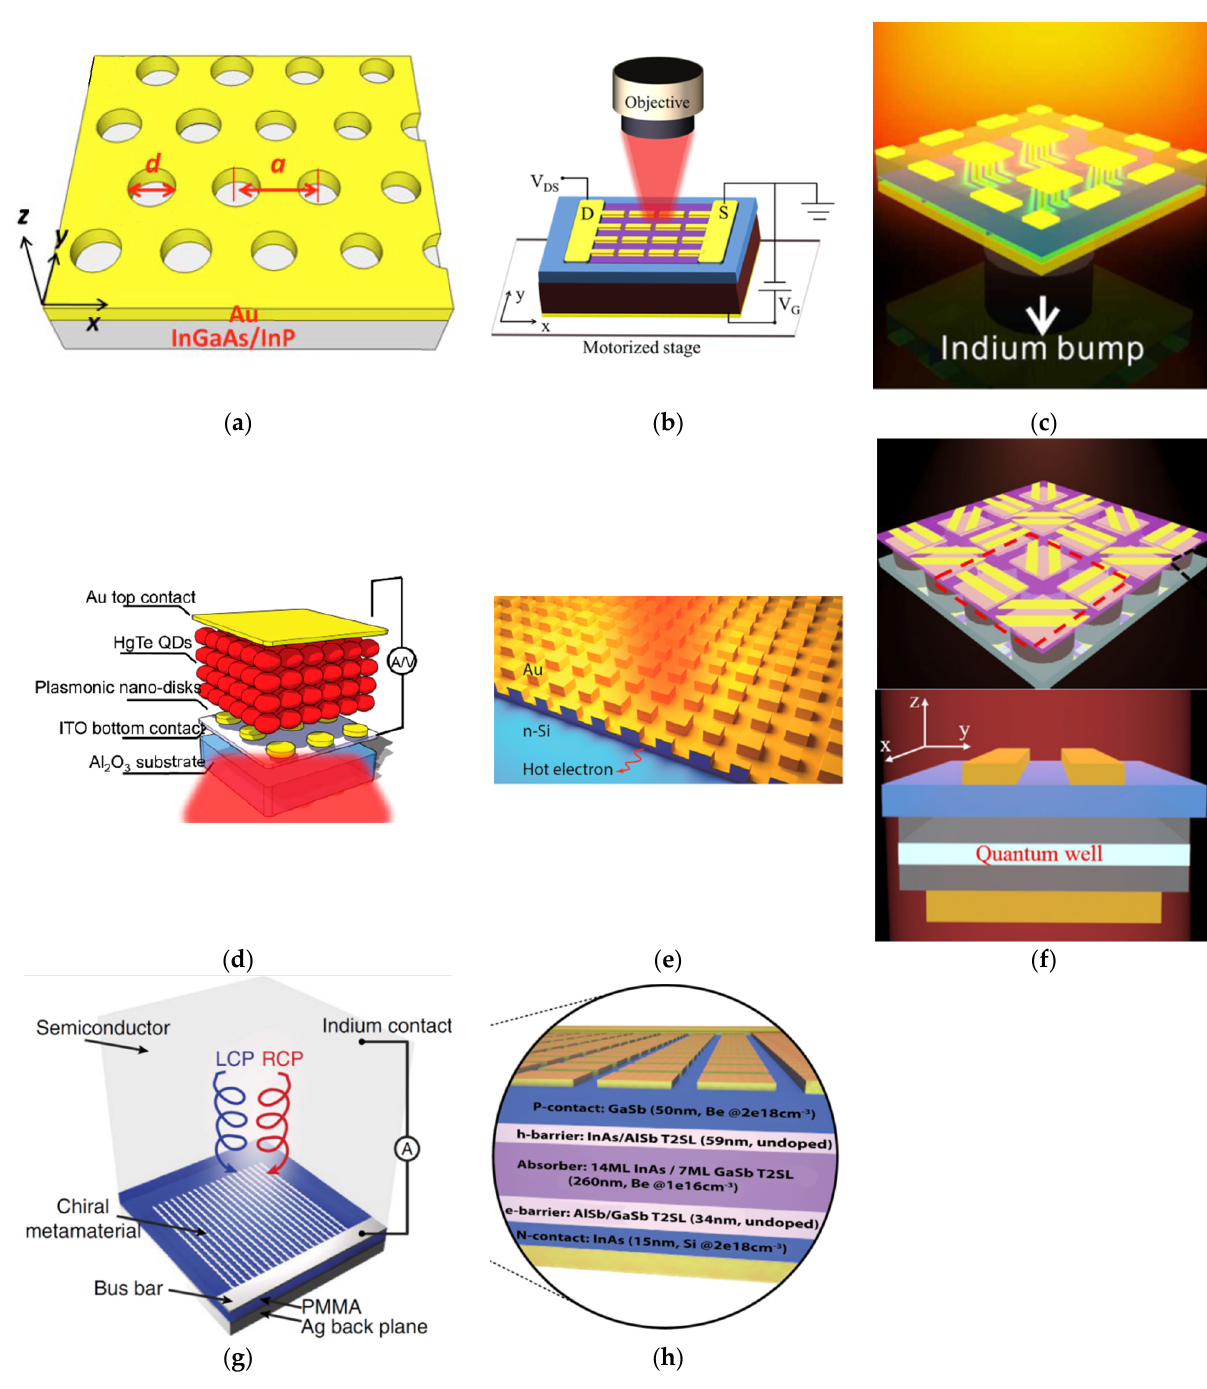
Figure 6. Examples of metasurface integrated photodetectors based on near field scattering: ( a ) SPRs assisted QWIP. ( b ) Plasmonic nanoantenna integrated Graphene photodetector. ( c ) LSPRs assisted QWIP FPA. ( d ) LSPRs assisted HgTe colloidal quantum dot photodetector. ( e ) Metamaterial perfect absorber Schottky photodetector. ( f ) LSPRs assisted linear polarization QWIP. ( g ) Chiral Schottky photodetectors. ( h ) Multi-spectral Type II Superlattice (T2SL) photodetector.